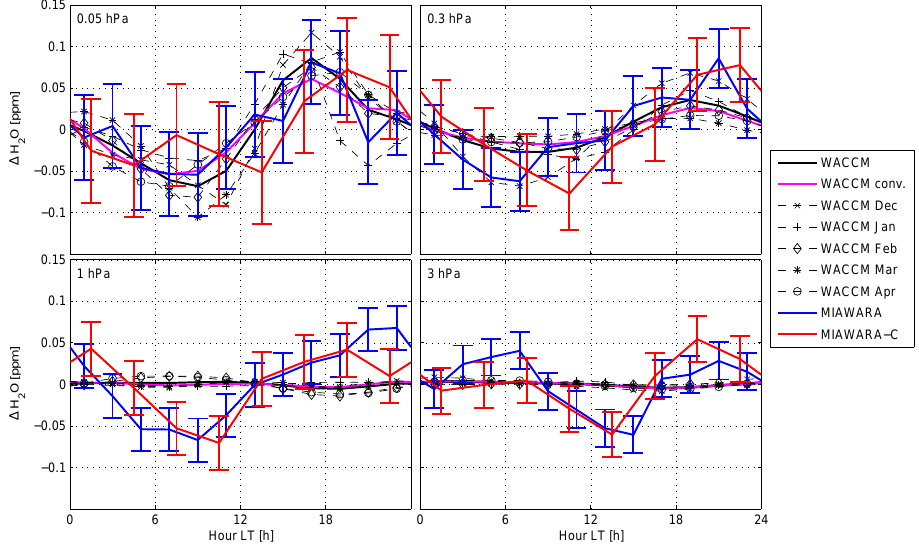
Fig. 2. Diurnal variations of water vapor as in Fig. 1 at four pressure levels (0.05, 0.3, 1 and 3hPa), including error bars for the observational data. The error bars are calculated by dividing the total uncertainty of an individual retrieval by the number of retrievals used for each bin. Systematic errors are not included. The solid black curve represents the 5-month average of the original WACCM data and the magenta curve represents the 5-month average of the convolved WACCM data. Also shown are the individual months (December to April) of the original WACCM